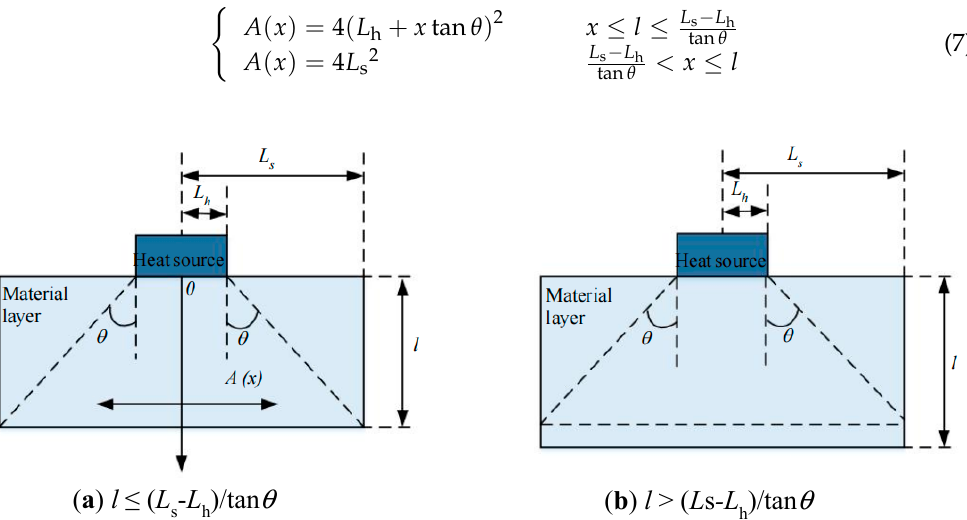
Figure 8. Lateral diffusion of heat from the heat source.